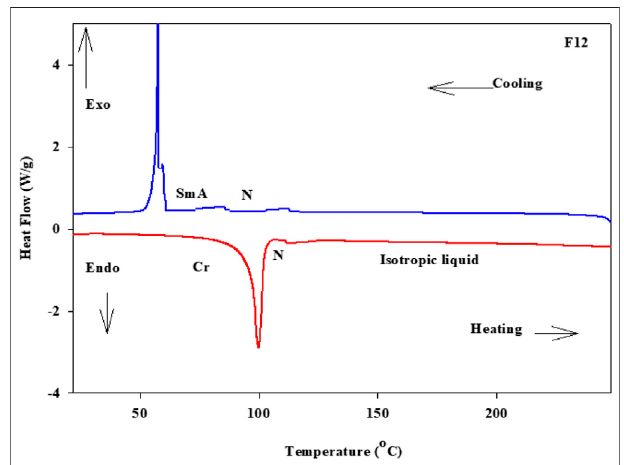
FIGURE 1 | DSC thermograms of F 12 which are measured from the 2 nd heating/cooling cycles at a rate of ± 10 ° C/min.